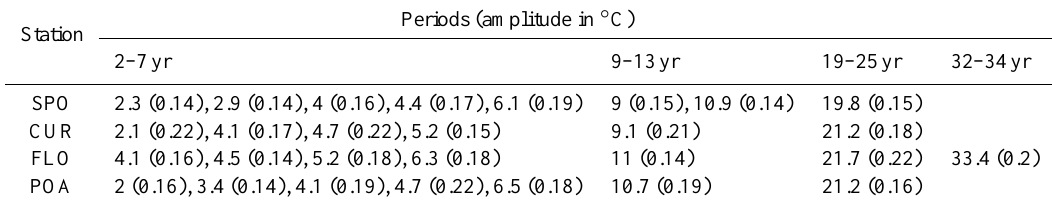
Table 2. Statistically significant periods in the temperature data for each